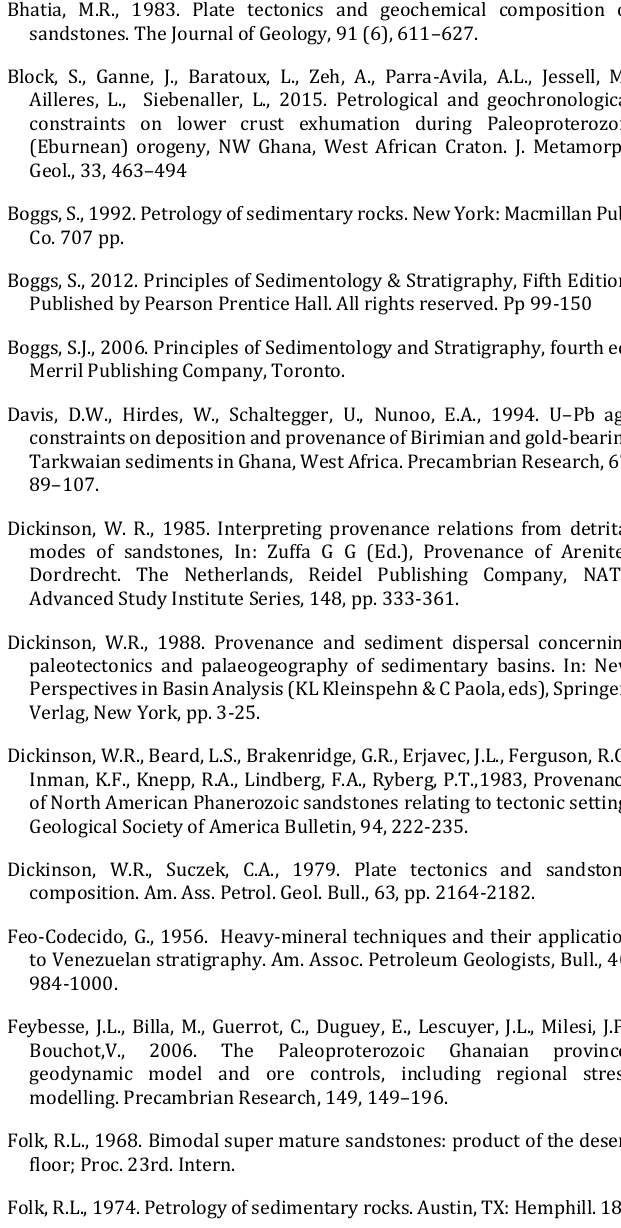
Figure 6: (A) QLF plot after Suttner and Dutta showing the paleoclimate environments of the sandstones B) In (Q/F) and In (Q/R) binary plot showing source rock composition, relief and paleoclimate conditions (Suttner and Dutta, 1986; Weltje, 1994).